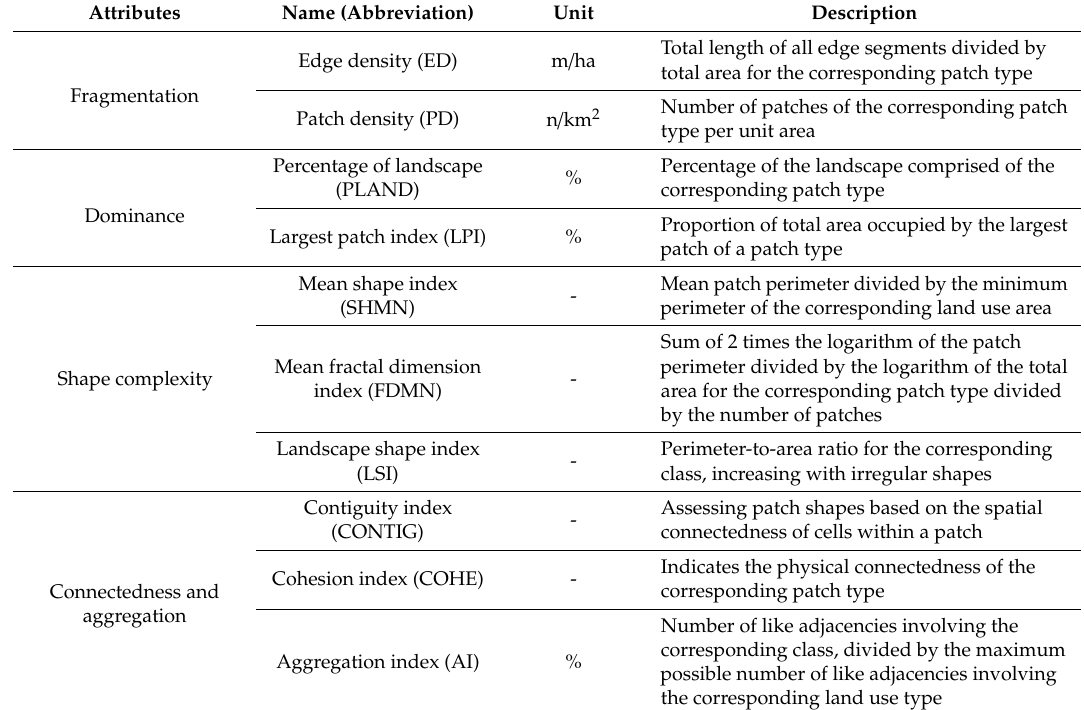
Table 2. Description of the landscape metrics selected at the class